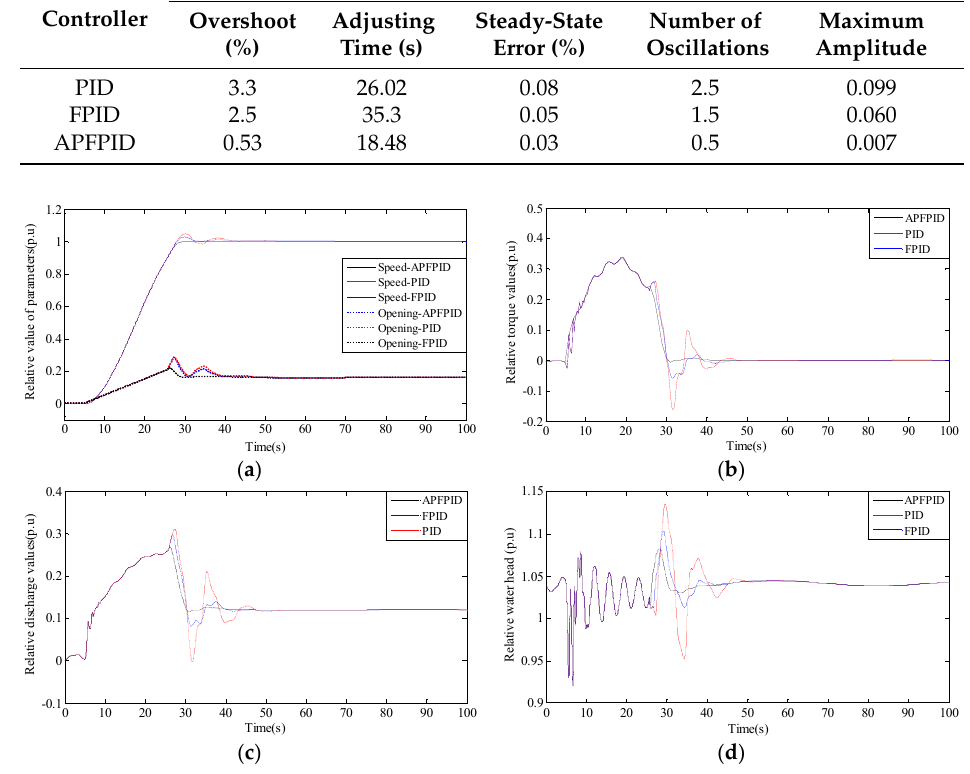
Figure 15. Transient process of no-load start-up conditions with different controllers: ( a ) rotational speed and opening; ( b ) torque value; ( c ) discharge value; ( d ) working head value of unit.